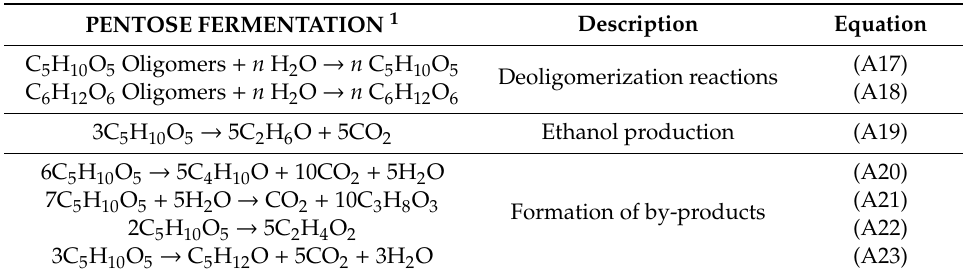
Table A8. Pentose fermentation reactions.